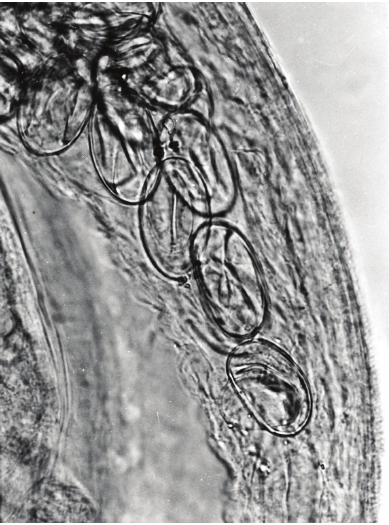
Figure 21: Embryonated eggs in the uterus of Rabbium paradoxus